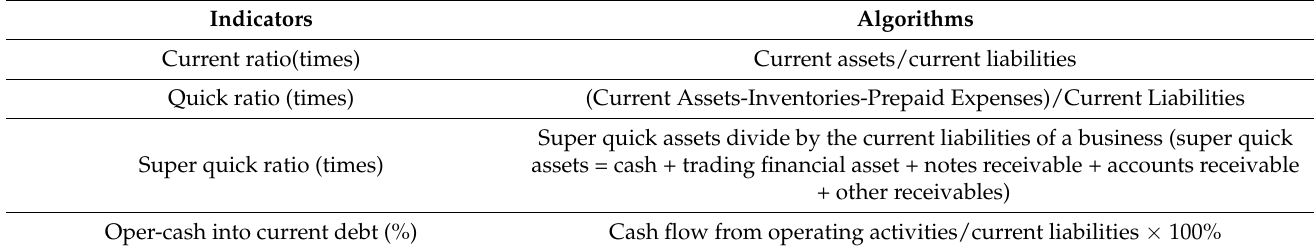
Table 7. Indicators and algorithms of the short-term solvency index.